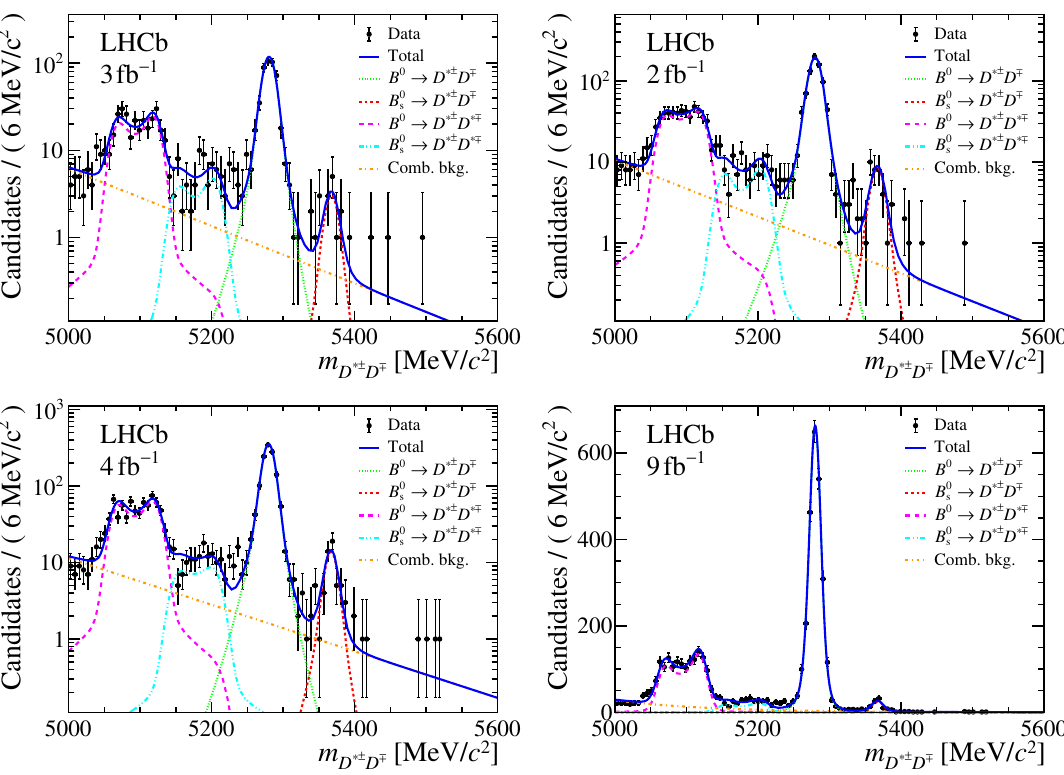
Figure 3 . The D mass distributions for (top left) 2011–2012, (top right) 2015–2016, (bottom ∗± D ∓ left) 2017–2018 data in logarithmic scale, and (bottom right) the combined data sample in linear scale. The total fit projection is shown as the blue solid line. The green dotted and the red dashed lines correspond to the signal contributions for the B 0 and B 0 decays, respectively. The orange s dash-dotted line corresponds to the combinatorial background contribution. The B 0 → D ∗± D ∗∓ and B 0 → D background components are described by the magenta long-dashed and the cyan ∗± D ∗∓ s long-dashed-two-dotted